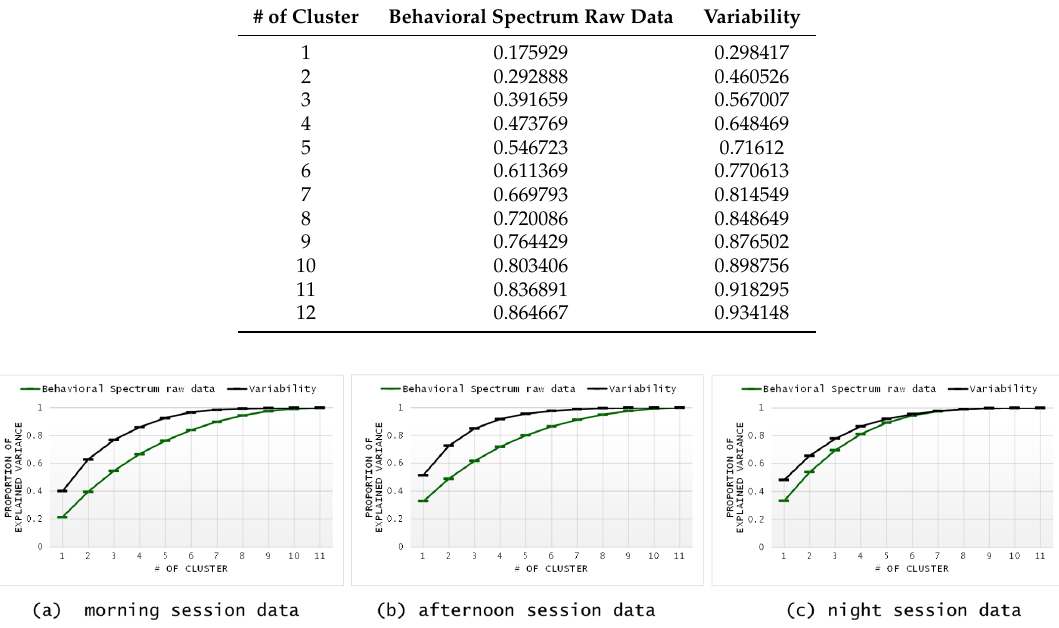
Figure 9. Proportion of explained variance in the data of behavioral spectrum raw data/variability by the number of clusters for the CU smart home dataset. Table 5. Explained variance by the number of clusters in the CU smart home data. Note that one subject participated in the experiment 4 times, resulting in data with 28 subjects instead of 24.